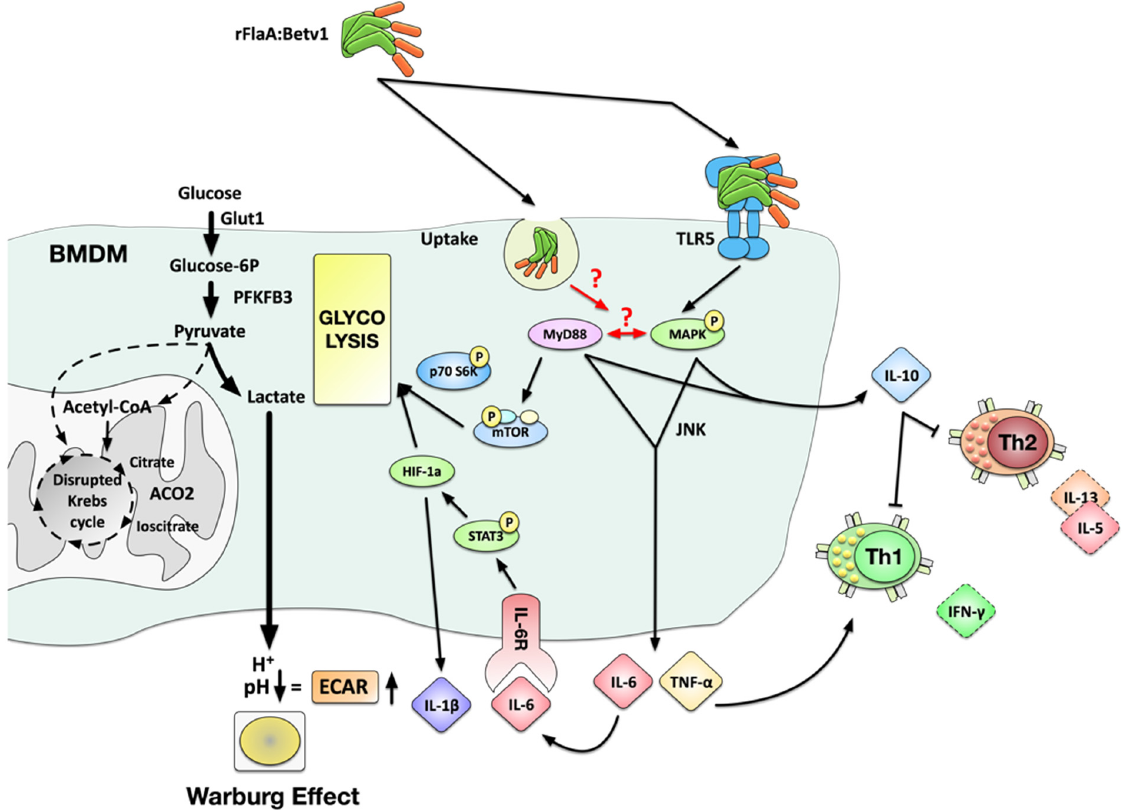
Figure 9. Suggested molecular signaling events contributing to rFlaA:Betv1-mediated activation of BMDMs. Stimulation of BMDM with aggregated rFlaA:Betv1 results in both TLR5-dependent and -independent uptake, leading to the activation of both MyD88 − and MAPK-mediated signaling cascades. rFlaA:Betv1-induced pro-inflammatory IL-6 and TNF- α secretion were shown to be MyD88 − and MAPK-dependent, likely promoting the induction of IFN- γ -producing Th1 cells in BMDM:TC co-cultures. Western blot analysis confirmed rFlaA:Betv1 to trigger STAT3 activation, increasing the expression of HIF-1a, which is likely to be responsible for the observed IL-1 β secretion. Metabolically, we found a MyD88-dependent phosphorylation of the mTOR target protein p70 S6 kinase, which together with HIF-1a likely mediated the observed shift towards enhanced glycolysis with increased levels of the glucose transporter Glut-1 and PFKFB3, and the induction of the Warburg effect while being paralleled by a decreased expression of mitochondrial proteins such as ACO2 and reduced oxygen consumption rates, suggesting a disrupted Krebs cycle in these cells. Finally, TLR5, MyD88, and MAPK activation were shown to be involved in the rFlaA:Betv1-induced production of the anti-inflammatory cytokine IL-10 that likely caused the observed suppression of rBet v 1-induced Th1 and Th2 responses in BMDM:TC